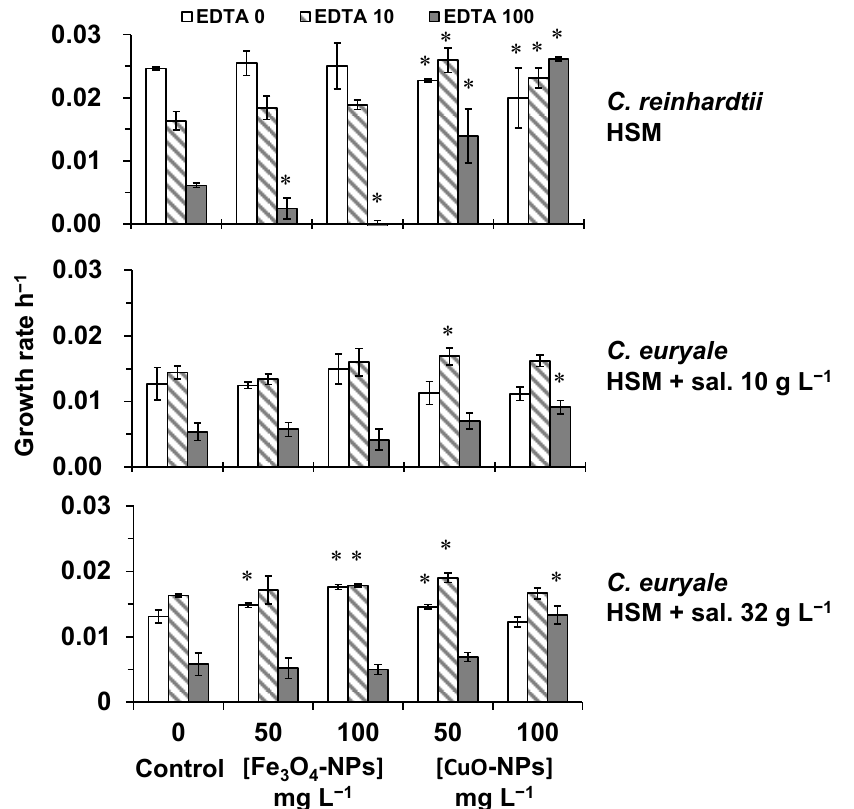
Figure 4. Growth rate (h − 1 ) of algal cells exposed during 72 h to 50 and 100 mg L − 1 of Fe 3 O 4 -NPs or CuO-NPs for C. reinhardtii in HSM, and C. euryale in HSM under two salinity conditions, 10 g L − 1 and 32 g L − 1 . Tested concentrations of EDTA: 0 mg L − 1 (white), 10 mg L − 1 (dash) and 100 mg L − 1 (gray). (*) Significant differences between the controls and treatments ( p < 0.05) were determined by one-way ANOVA and Tukey post-hoc